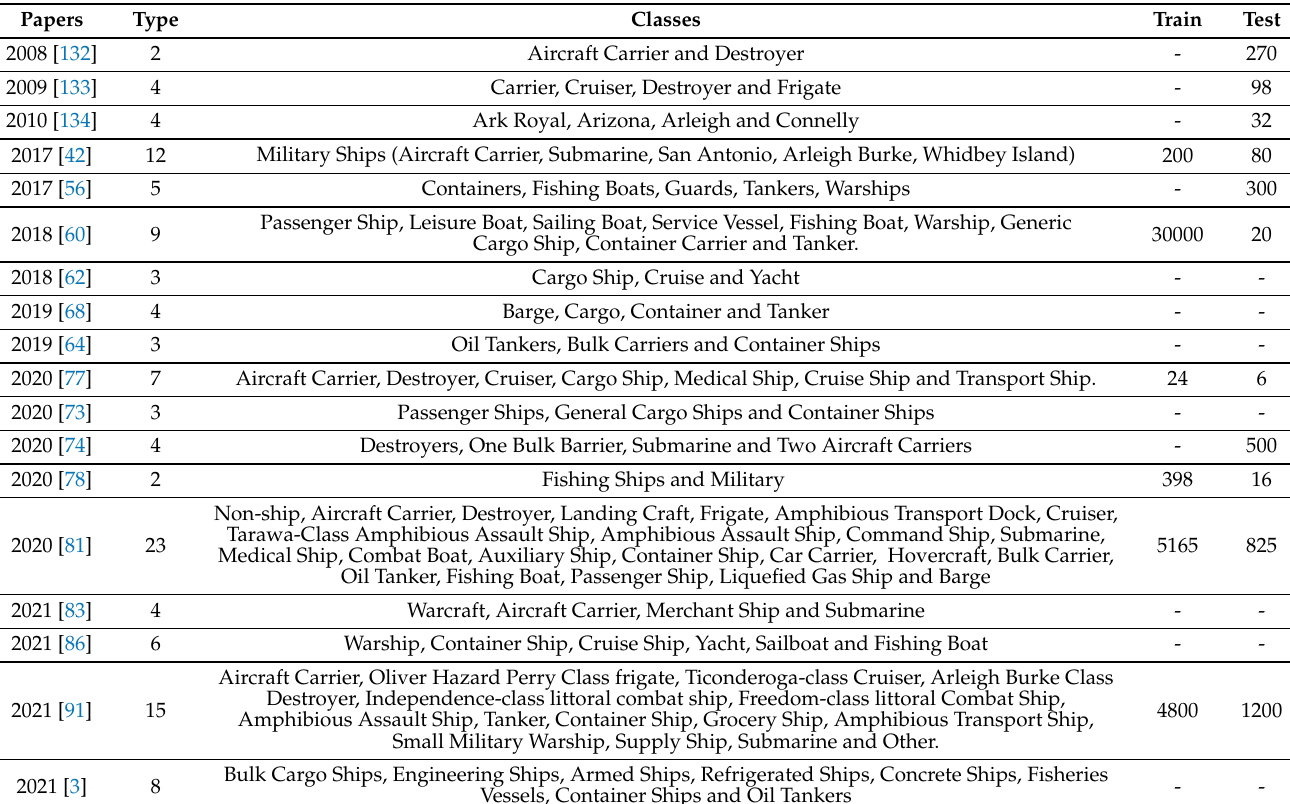
Table 5. Class division in related